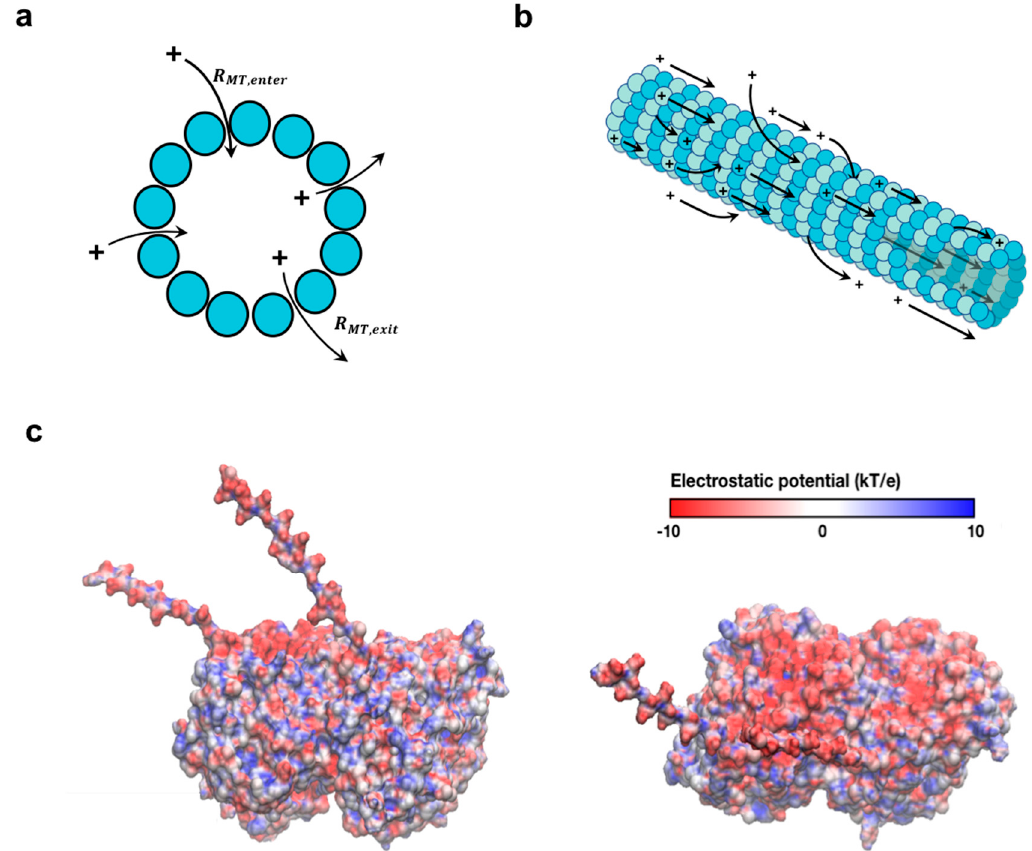
Figure9. SchematicofchargetransportalongandacrossanMT.( a )Arepresentationofchargeflowacross the MT cross section through nanopores present between adjacent protofilaments. ( b ) A representation of charge flow through both inner and outer modes along an MT. Arrows depict charge flow via both mechanisms, enabling MT charge storage across a broad spectrum of frequencies, and charge transport at low AC frequencies in the cell. ( c ) Side view (left) and top view (right) of the tubulin dimer, displaying distribution of electrostatic potential at di ff erent locations. The negatively charged C-termini face towards the solution and contains ~50% of the total negative charge on a tubulin dimer. Coherent oscillations of these C-terminal tails are modelled to generate solitonic pulses of mobile charge along the outer surface of an MT, creating ionic currents along its length [7,44,50]. Ions from